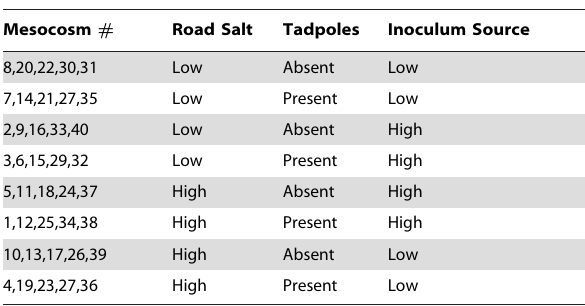
Table 1. 2 6 2 6 2 factorial design applied to 40 outdoor mesocosms (n=5 per treatment combination) with a road salt treatment (low or high), tadpole treatment (present or absent) and inoculum treatment (collected from low or high conductance stormwater